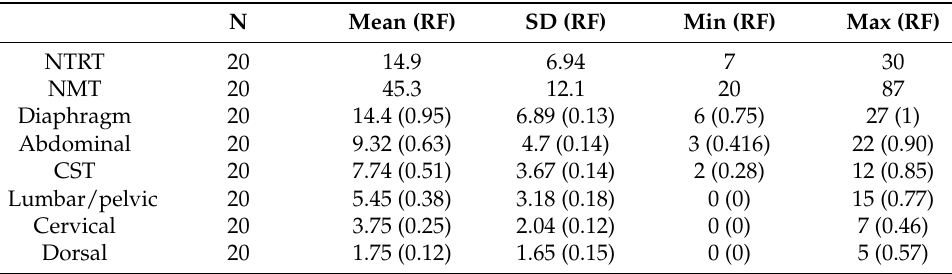
Table 3. Characteristics of treated regions, number of performed treatments, number of performed manipulative techniques, and relative frequency (RF) of treated region per